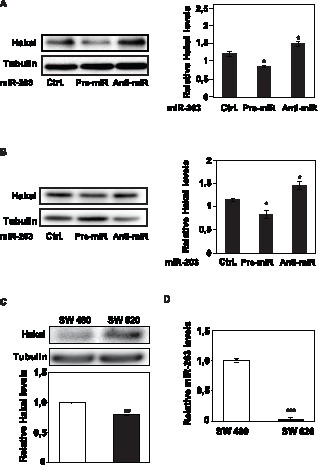
Influence of miR-203 on Hakai levels in several cell lines.A, the effect of modulating miR-203 levels in 293 cells was studied as described in 1D and 1E; Western blot analysis (left panel) and quantification by densitometry (right panel). B, the effect of modulating miR-203 levels in A549 cells was studied as described 1D and 1E. Western blot analysis (left panel) and quantification by densitometry (right panel). C, endogenous Hakai expression levels in human colorectal cell lines (SW480 and SW620), as assessed by western blotting (upper panel) and by RT-qPCR (lower panel) analysis. D, endogenous miR-203 levels in human colorectal cell lines (SW480 and SW620) by RT-qPCR (lower panel). Values (A–D) are the means ± SEM from three independent experiments. Significant differences in the indicated transfected miRNA with respect to transfected scrambled control (Ctrl) miRNA for A–B, and the between SW480 and SW620 cell lines for C–D are indicated (*p<0.05, **p<0.01, ***p<0.001, n = 3). The western blotting data are representative of three independent experiments.